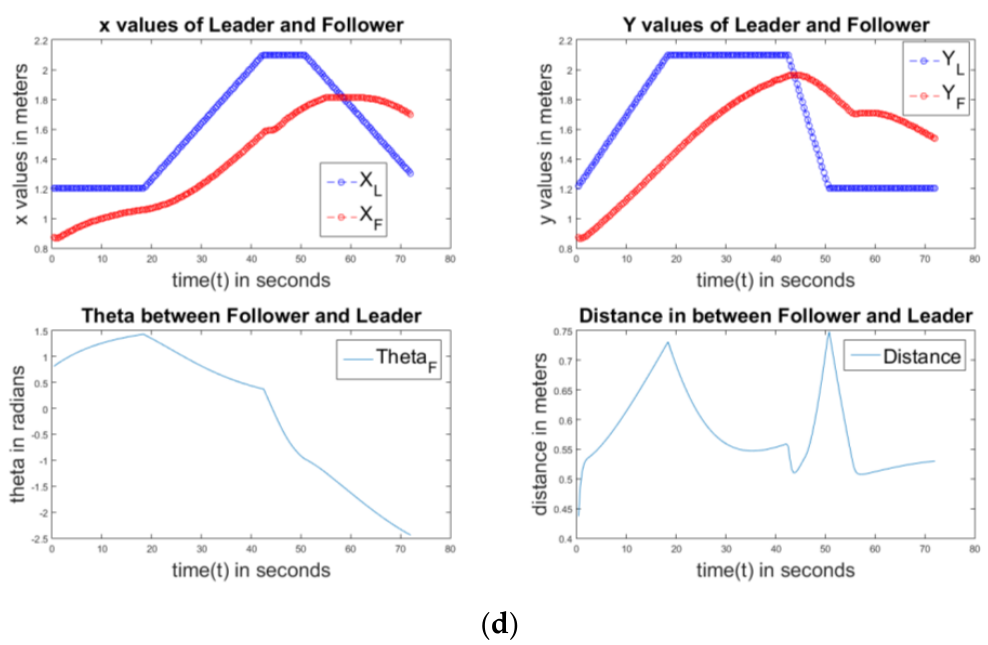
Figure 12. ( a ) PI controller of a circle; ( b ) PI controller of an ellipse; ( c ) PI controller of a line; ( d ) PI controller of a square.